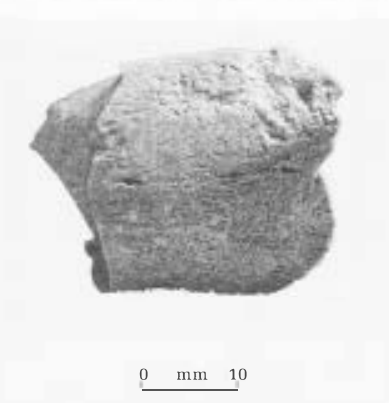
Figure 10 The end of a bone hammer, used in the final stage of handaxe manu­